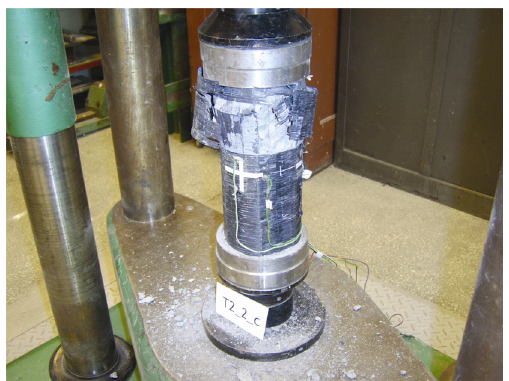
Fig. 13. Typical failure of CFRP confined concrete cylinders in a compression test – stage II